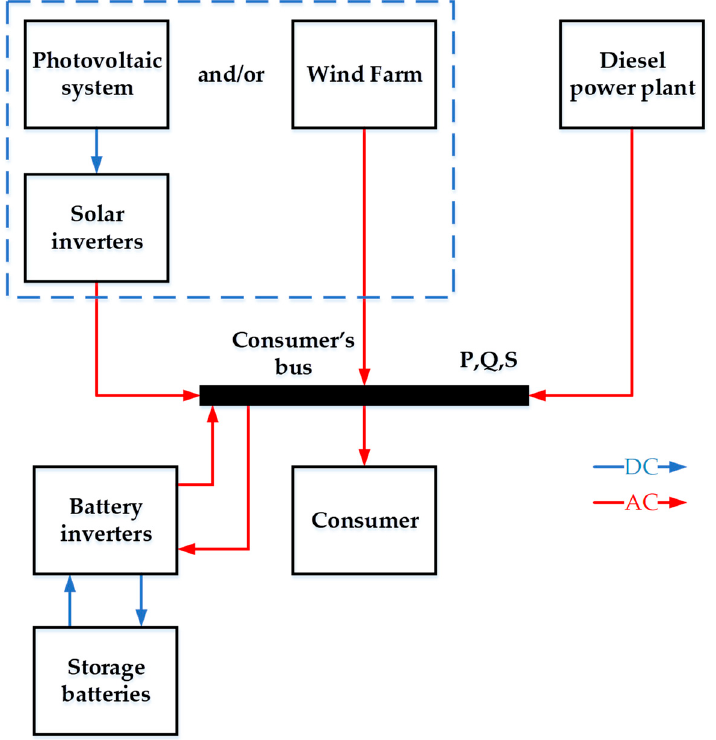
Figure 3. Operation of a hybrid energy system with renewable energy sources and storage batteries.